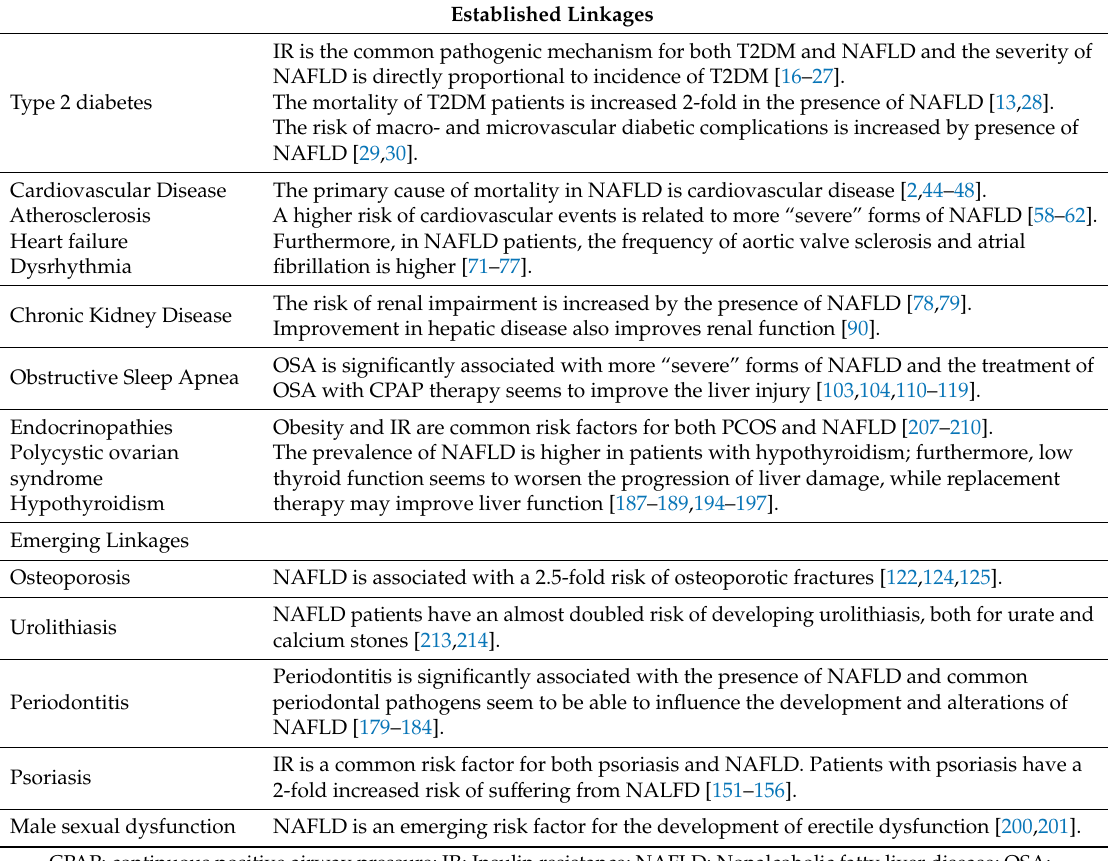
Table A1. Key concepts of extra-hepatic manifestations of nonalcoholic fatty liver disease (NAFLD). Established Linkages